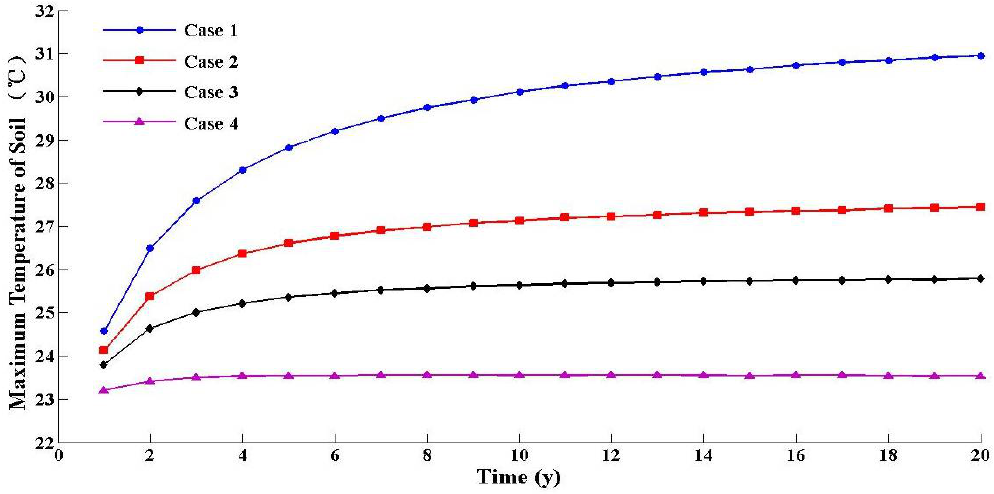
Figure 7. Yearly average maximum temperatures.